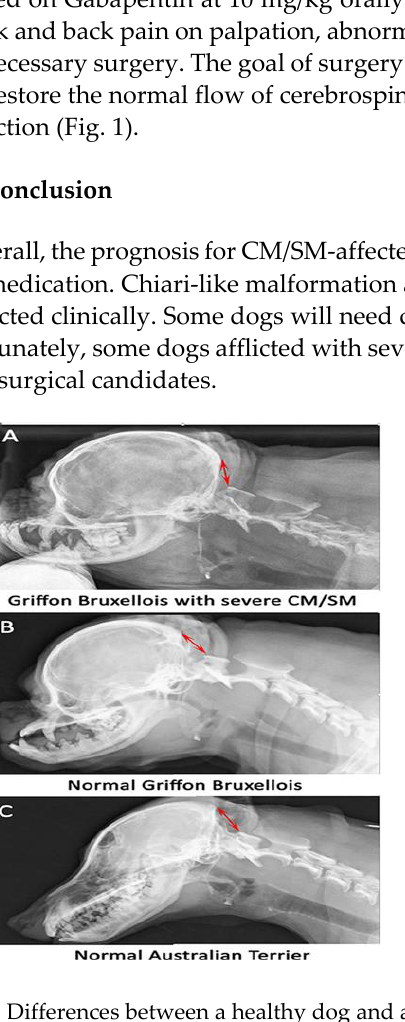
Fig.1 Differences between a healthy dog and a Fig. 2 Chiari malformation and Syringomyelia seen on a CT dog with Syringomyelia (https://www.fron- tiersin.org/arti-